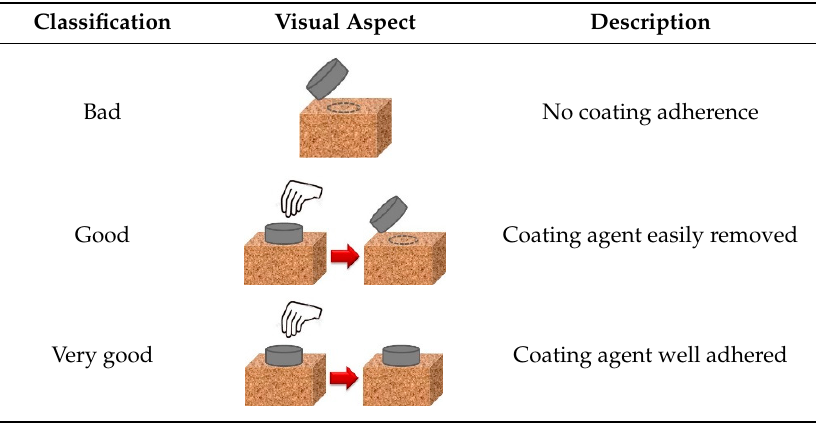
Table 1. Classification of bricks after each cycle of contact coating test.